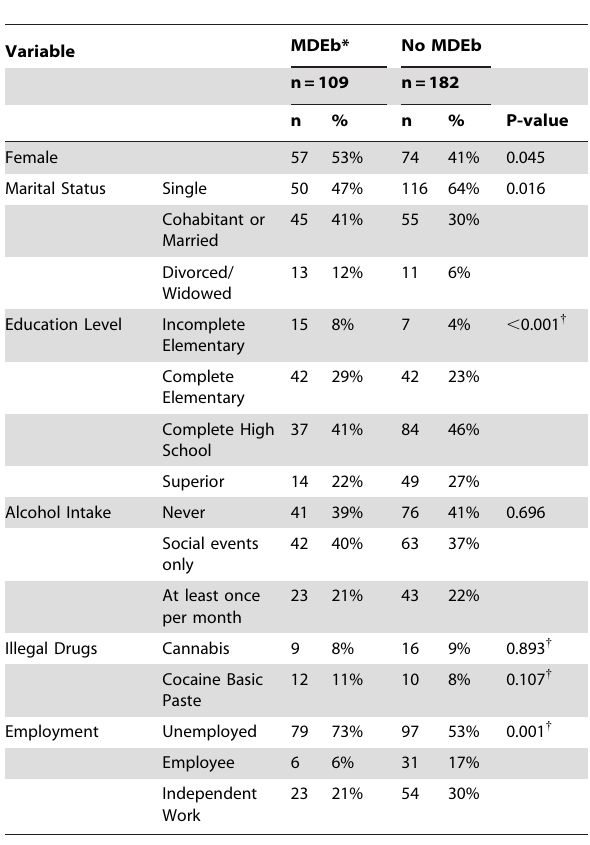
Table 1. Sample description at baseline by main predictor